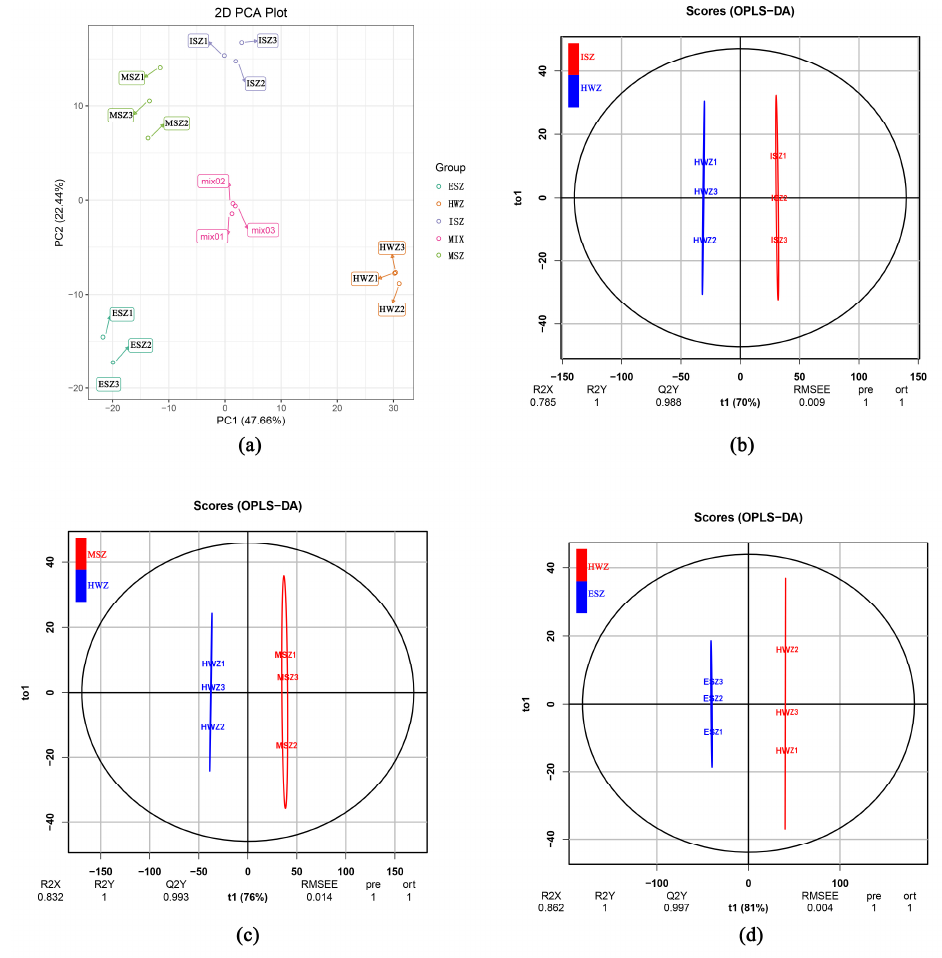
Figure 3. Differential metabolite analysis using principal component analysis (PCA) and orthogonal projections to latent structures-discriminant analysis (OPLS-DA). ( a ) PCA score plots. ( b – d ) OPLS-DA model plots for the comparison groups HWZ vs ISZ ( b ), HWZ vs MSZ ( c ), and HWZ vs ESZ ( d ).